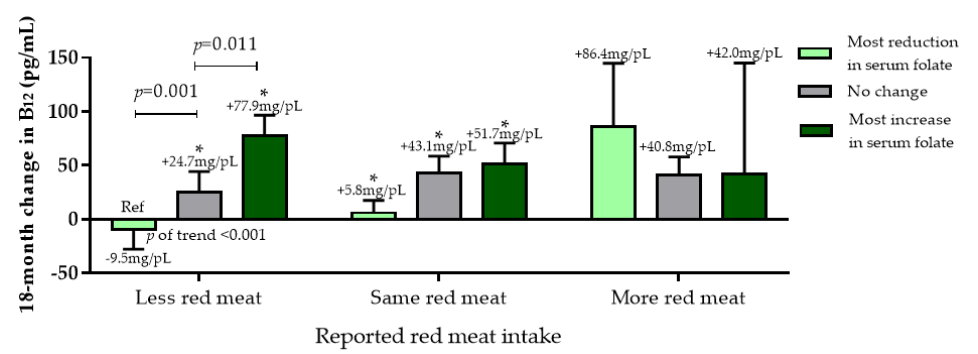
Figure 5. Red meat consumption change at the end of the intervention (tertiles) vs. 18-month serum folate change (tertiles) vs. 18-month change in vitamin B 12. * indicated within-group significance (baseline vs. T18) at the 0.05 level. Data presented as means and SEM.